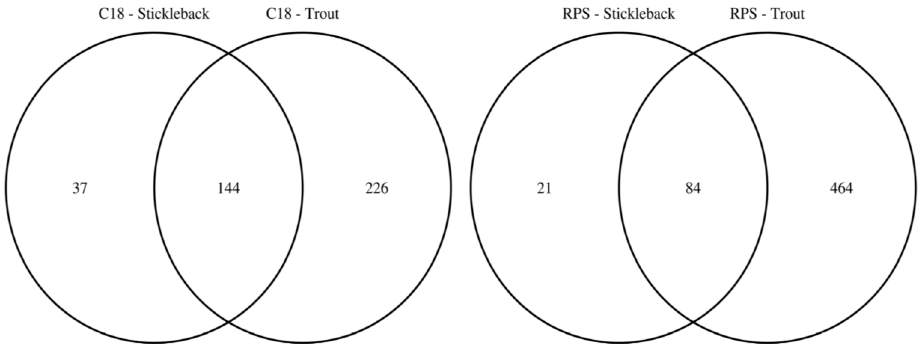
Figure 3. Venn diagrams highlighting the larger number of exometabolic peaks arising from rainbow trout versus three-spined stickleback, by showing the numbers of putatively annotated metabolites excreted from each fish species using C18 and SDB-RPS Empore™ disks in a Chemcatcher ® passive sampler. The majority of peaks measured from stickleback are also observed in the trout datasets.